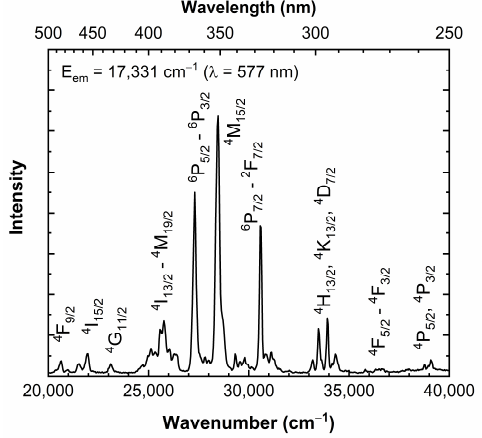
Figure 8. Excitation spectrum between 20,000–40,000 cm −1 recorded at T = 78 K for the 4 F 9/2 → 6 H 13/2 emission at 17,331 cm −1 in the LYB:Dy(1 mol%) single crystal. According to [10,35,36] the 4 F 9/2 → 6 H 15/2 transition is an allowed magnetic dipole tran- sition and the 4 F 9/2 → 6 H 13/2 transition belongs to a forced electric dipole transition being allowed only in the case when the Dy 3+ ion is located at a lattice site missing inversion center symmetry. Therefore, the fact that the group of yellow emission bands around 577 nm (17,331 cm −1 ) is the most intense one in the spectrum confirms that Dy 3+ ions occupy Y 3+ sites in Li 6 Y(BO 3 ) 3 single crystals, resulting in the hypersensitive ( 4 F 9/2 → 6 H 13/2 ) transi- tion. This is in accordance with the results reported earlier for the Li 6 Y(BO 3 ) 3 :Dy 3+ phos- phor [10]. Indicatively, the ratio of the intensities of the 4 F 9/2 → 6 H 13/2 and 4 F 9/2 → 6 H 15/2 emissions is much lower in glass samples [12] than in crystals. This difference originates